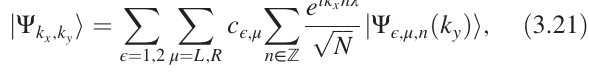
ffiffiffi p 2 . The coefficients c ϵ ; μ are